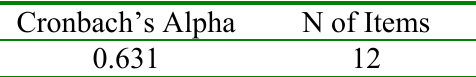
Reliability Statistic for the Reading Test ( N